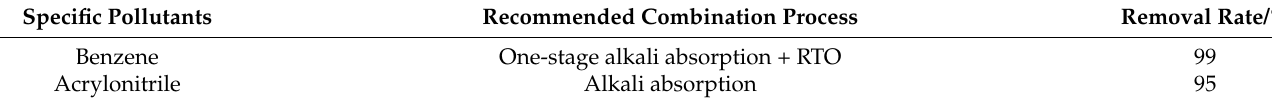
Table 5. Recommended combined processes and removal rates of specific